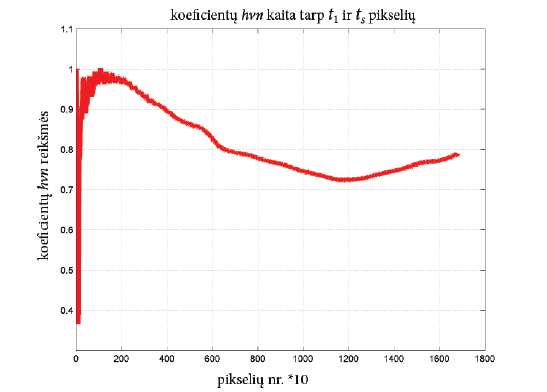
Fig. 5. Normalized covariance function of the digital image for the lens of the eye without contact lens